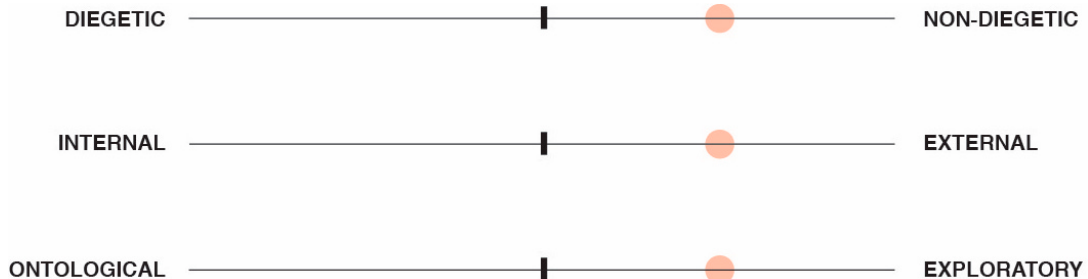
Figure 2. Mapping the Tangible Spatial Narratives project onto the TENF .